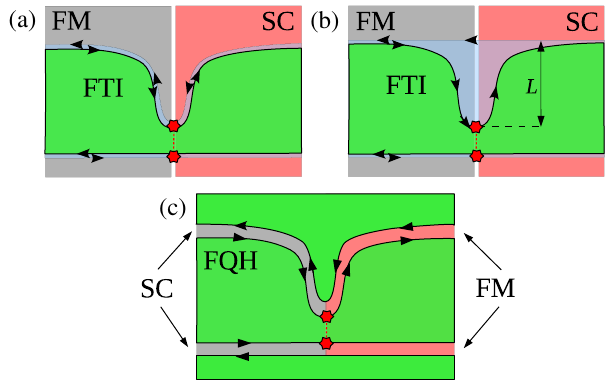
FIG. 6. Constrictions in the FTI and FQH realizations. We view the FTI as a combination of two FQH droplets with opposite spins and opposite filling fractions. The arrows show the direction of propagation of the edge states of the two FQH droplets. The red stars and lines indicate quasiparticle tunneling between the SC-FM interfaces on the edges. (a) Constriction in a FTI realiza- tion created by a gate potential, which acts on both spin species. In this case, quasiparticles of both spin species can tunnel across the constriction.(b)InaFTIrealization,applyingalocalZeemanfield splits the spin-up and spin-down edge states, such that only one spin species can tunnel across the constriction. (c) In the FQH realization, ‘‘spin up’’ and ‘‘spin down’’ indicate whether the quasiparticles are on the edge of the inner or outer droplet, respectively. (Both droplets have the same filling fraction.) the outer droplet, only one quasiparticle species can